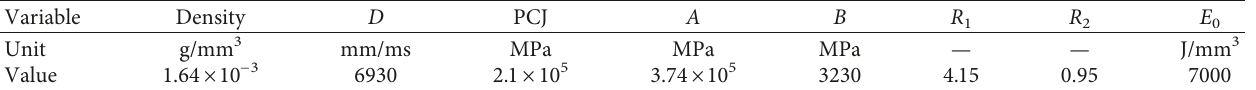
Table 2: Variables of TNT.